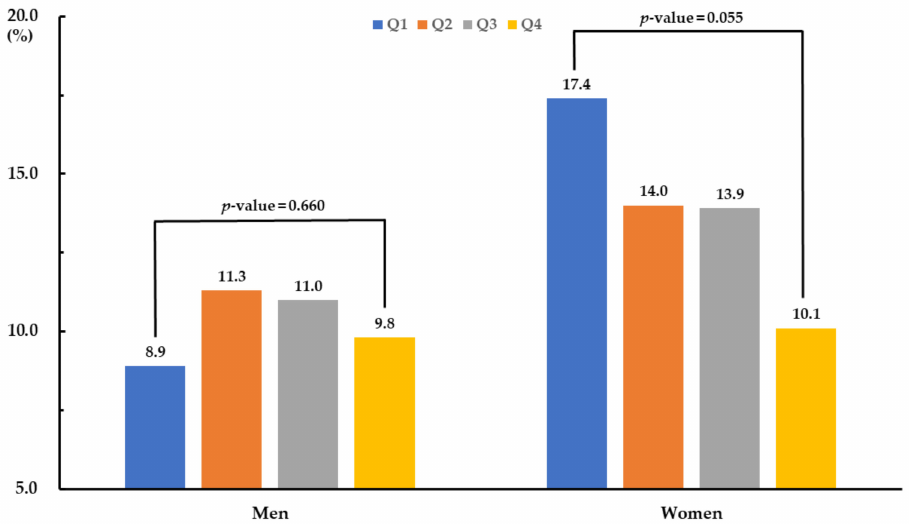
Figure 1. Prevalence of sarcopenic obesity according to quartile group of omega-3 fatty acid